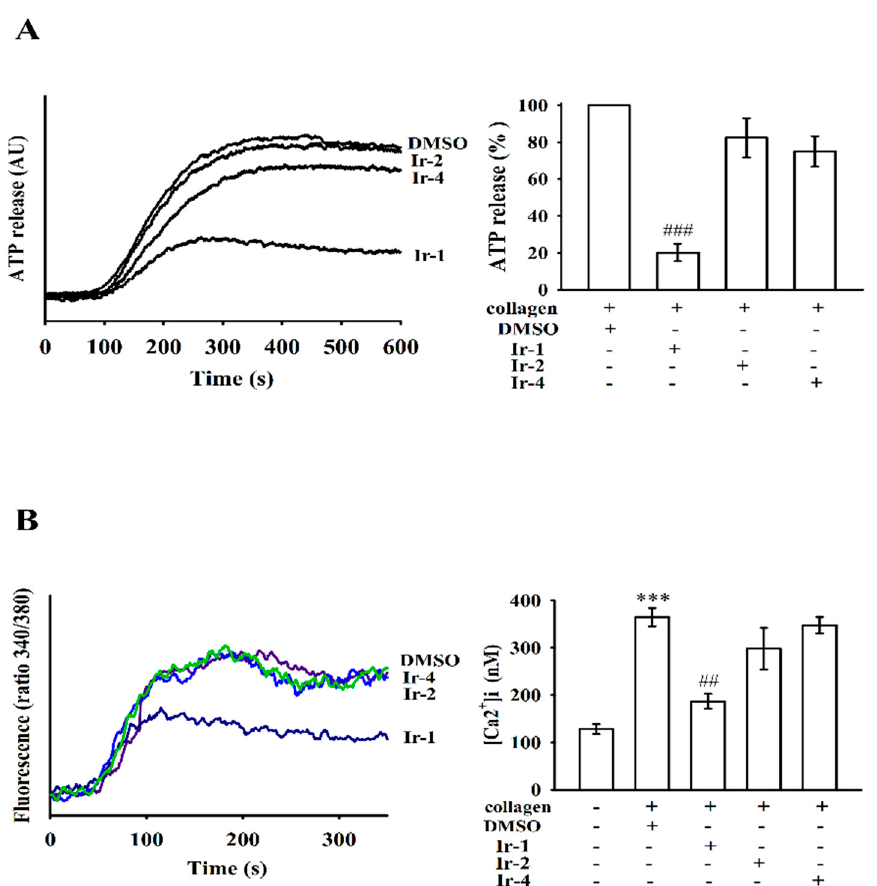
Figure 3. Effects of Ir-1, Ir-2 and Ir-4 on collagen induced ATP release and relative [Ca 2+ ]i mobilization in human platelets. Washed human platelets (3.6 × 10 8 cells/mL) were preincubated with 10 μ M Ir-1, Ir-2 and Ir-4 or a solvent control (0.1% DMSO) and subsequently treated with 1 μ g/mL of collagen to stimulate ATP release reaction ( A ), and to induce the cytoplasmic influx of Ca 2+ from intracellular stores ( B ) as described in the Section 4.3. and 4.4. Data are presented as the means ± S.E.M. ( n =